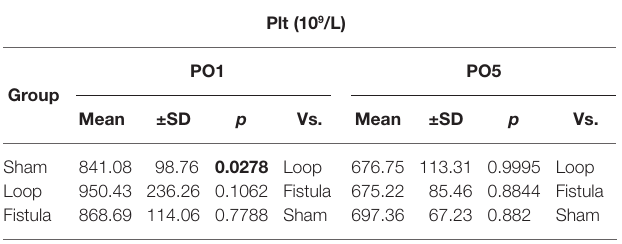
The bold means that the p values are at significant